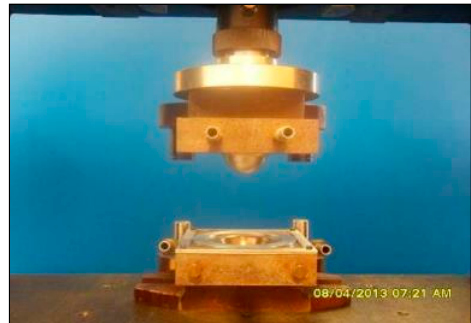
Figure 5. Dome forming setup using cold tooling conditions.